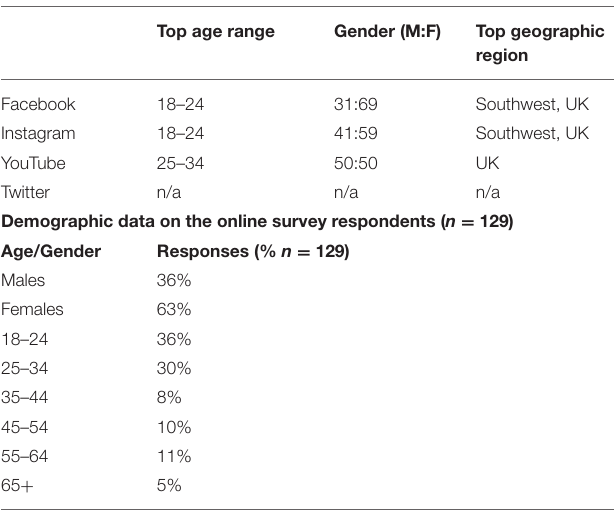
TABLE 1 | Key user insight data generated from imbedded social media analytic tools and online survey respondents. Facebook, Instagram, and YouTube User insight